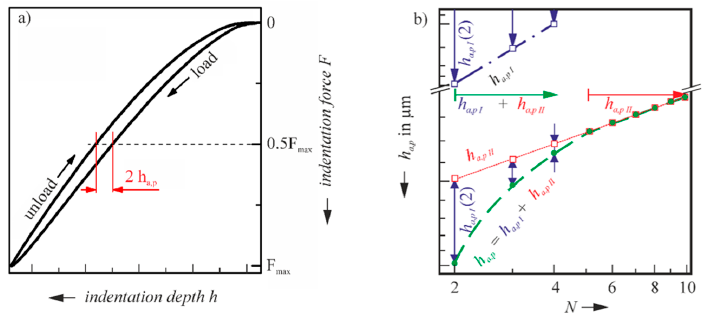
Figure 2. Description of the PHYBAL CHT with determination of the ( a ) h a,p and ( b ) power-law h a,pI for 2 ≤ N ≤ 4 and h a,pII for N > 4, reproduced from [11,12], with permission from Elsevier, 2019.